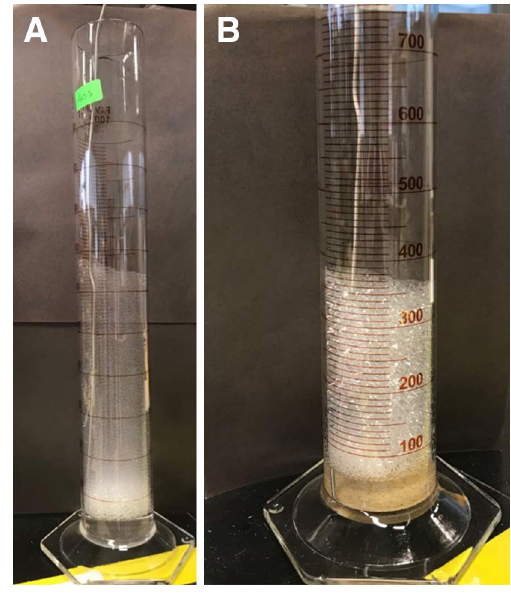
Fig. 1 Graduated cylinder used in bulk foam stability tests: a without sand and b with sand